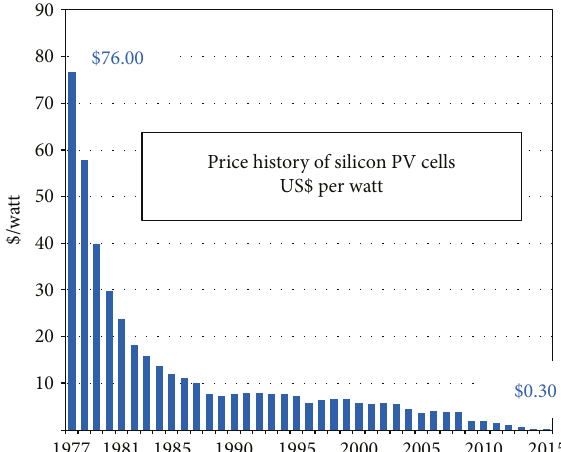
Figure 5: Graph of the development of the price of solar panels per